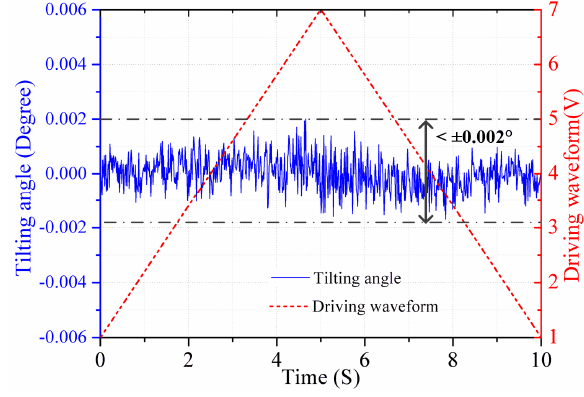
Figure 7. The residual tilt angle versus voltage under closed-loop control.